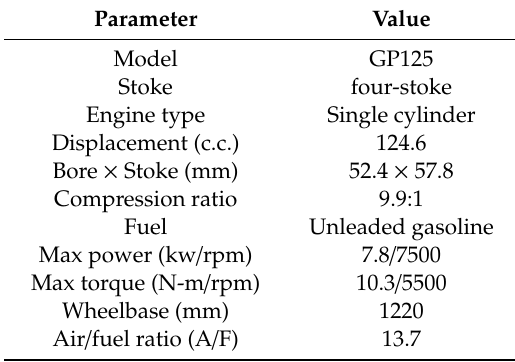
Figure 1. Schematic of this experiment and setup location. Table 1. The engine specification of motorcycle. Table 5. The range of each exhaust gas.